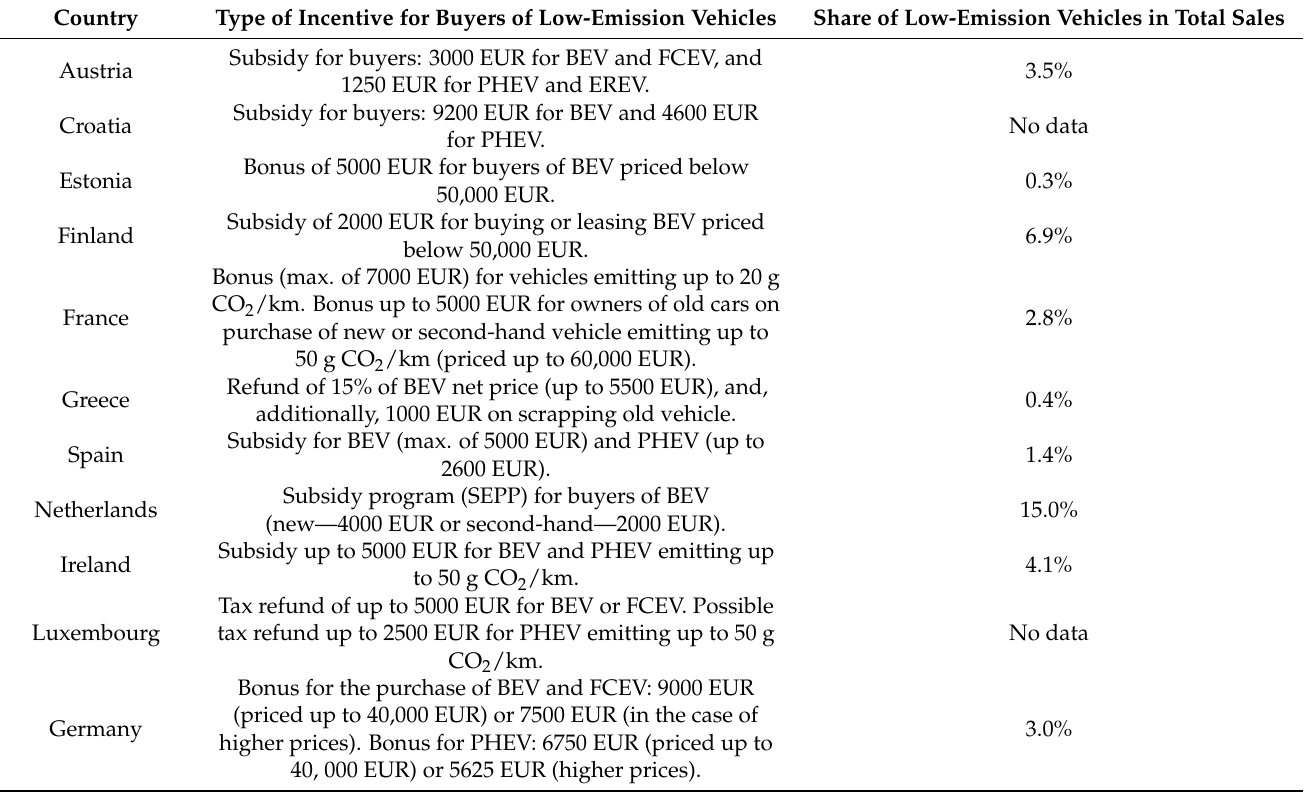
Table 7. A system of subsidies for the purchase of e-vehicles in various countries of the EU.